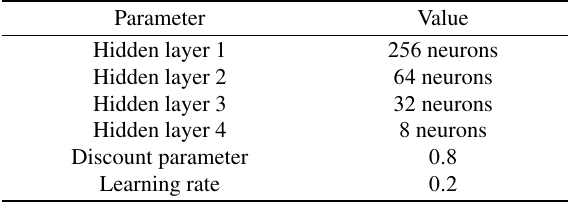
Table 2 Simulation